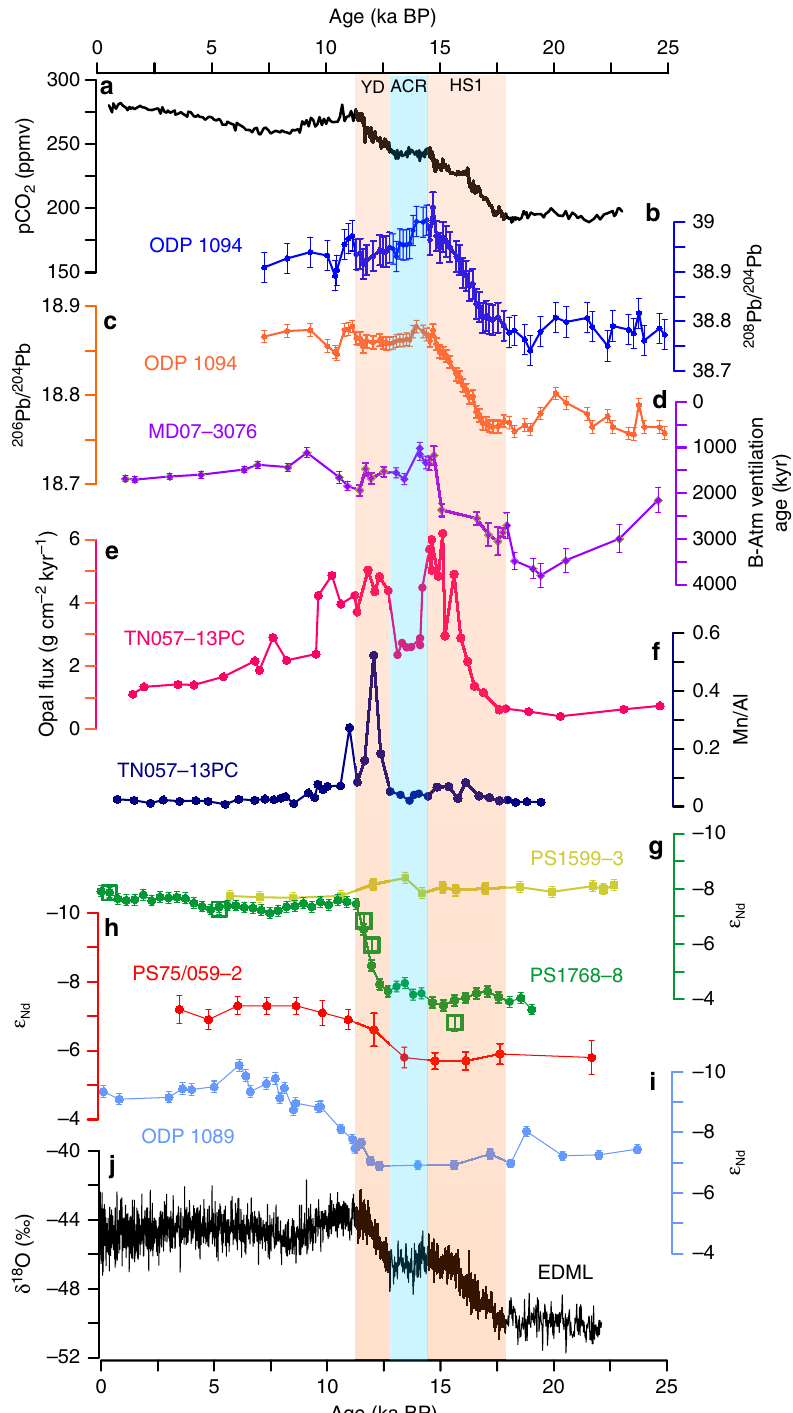
Fig. 2 Paleoclimatic reconstructions over the past 25,000 years. a Atmospheric pCO 2 concentrations from Antarctic Dome C ice core 6 and the West Antarctic Ice Sheet Divide ice core (WDC) 11 . b , c Authigenic Fe – Mn oxyhydroxide-based 206 Pb/ 204 Pb and 208 Pb/ 204 Pb records from ODP Site 1094. d Benthic – atmospheric (B – Atm) ventilation age 5 . e 230 Th-normalized biogenic opal fl ux 2 . f TN057-13PC sedimentary Mn/Al 4 . g ε Nd records extracted from bulk sediment from PS1599-3 (yellow – green circles) and PS1768-8 (darker green circles) and opal from PS1768-8 (open green squares). h Fish teeth and planktic foraminifera ε Nd of South Paci fi c core PS75/059-2 34 . i ε Nd records extracted from ODP Site 1089 39 . j EDML ice core δ 18 O 33 . Error bars correspond to the 2 σ external error of the 206 Pb/ 204 Pb, 208 Pb/ 204 Pb, and ε Nd measurements. The orange and blue boxes indicate periods of strong and diminished deglacial CO 2 rise. YD: Younger Dryas; ACR: Antarctic Cold Reversal; HS1: Heinrich Stadial